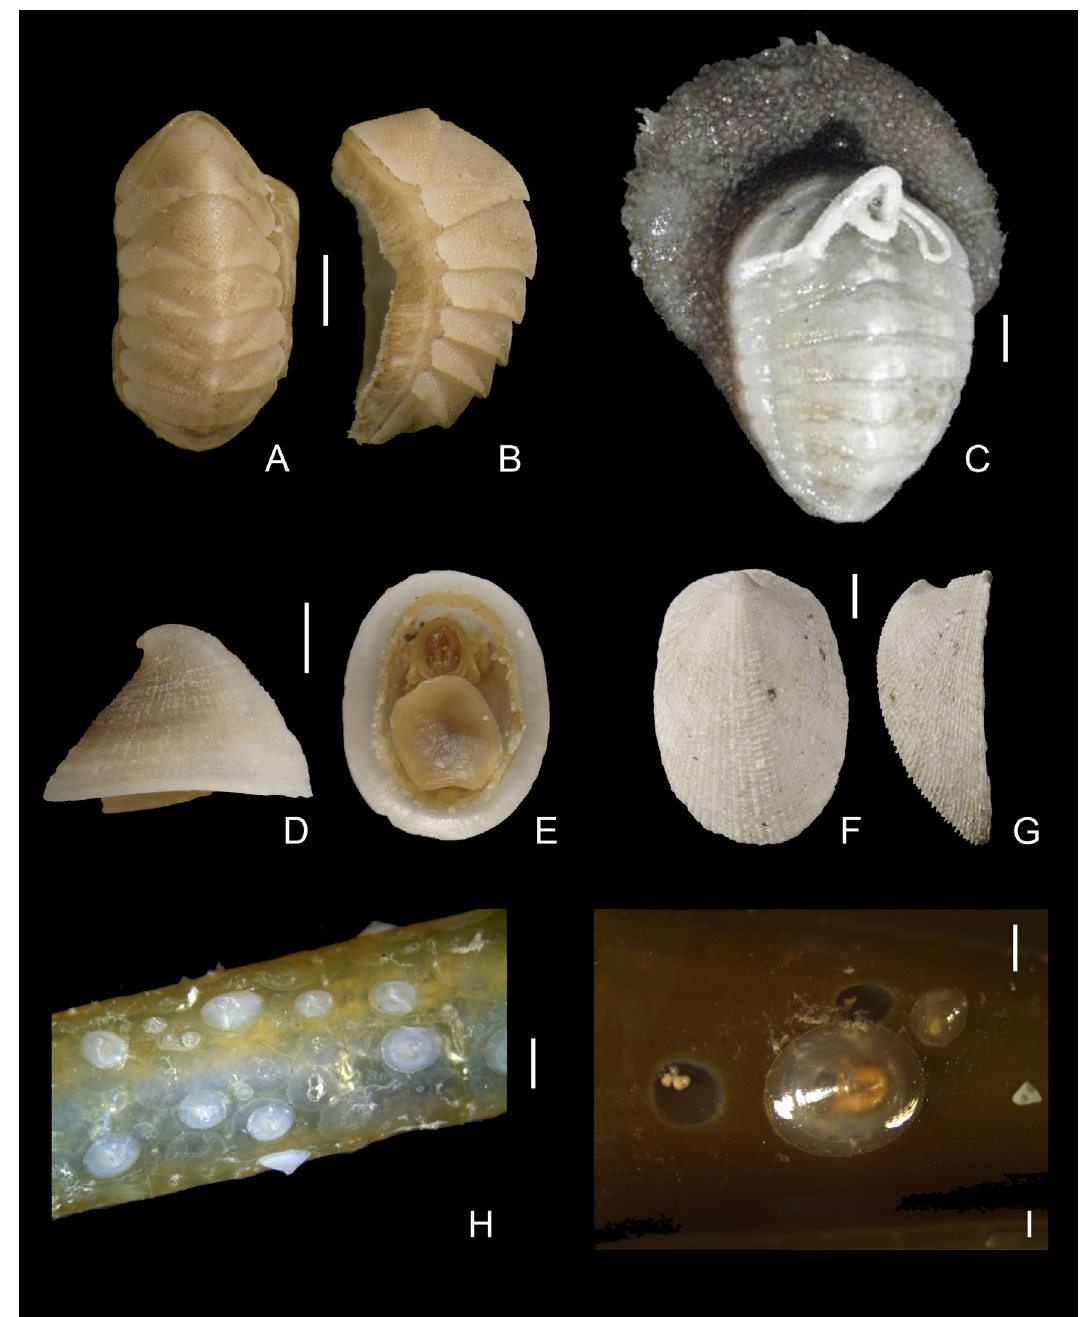
Fig. 3. Polyplacophora and Gastropoda (Patellogastropoda and Vetigastropoda